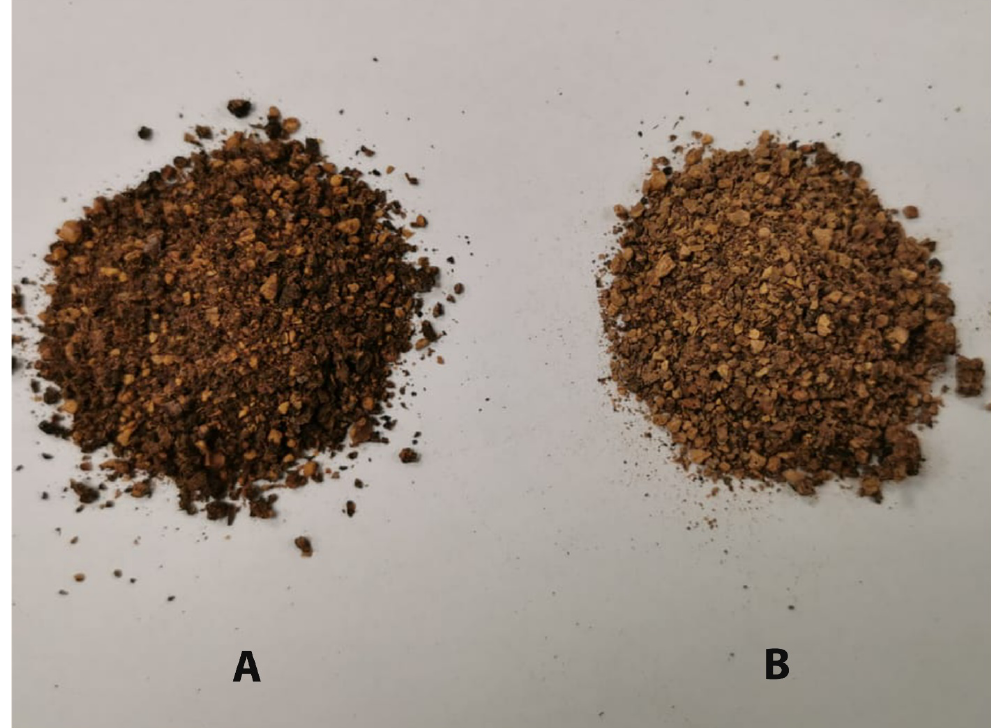
Figure 1. Solid waste of olive milling process (pomace), ( A ) before solvent extraction. ( B ) After solvent